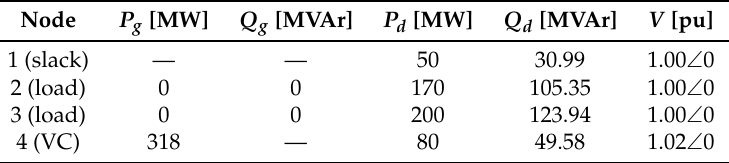
Table 7. Nodal parameters of the four-node test feeder.